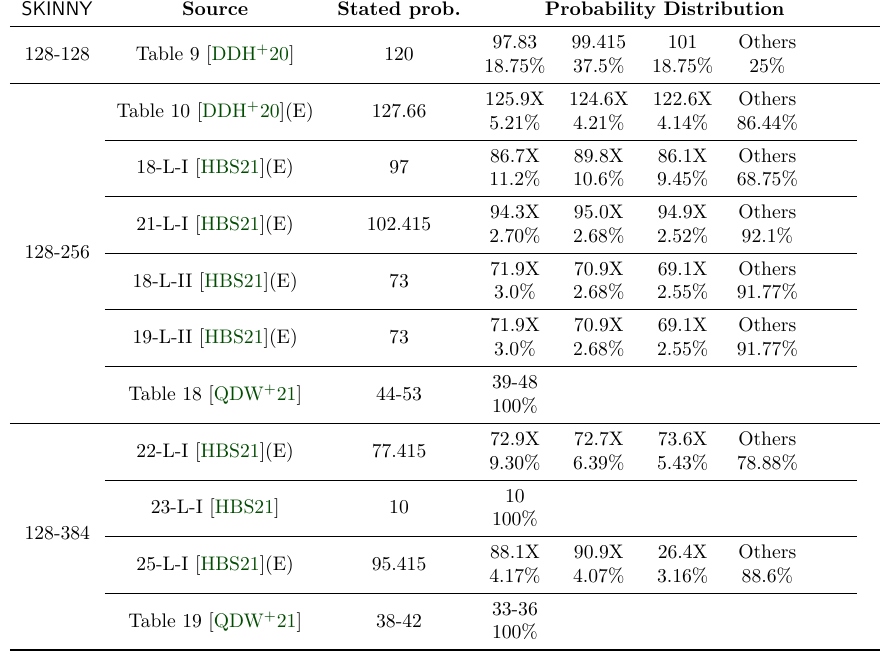
Table 7: The probability distribution estimation for each differential characteristic from Table 2. “Stated prob.” refers to the − log The first row in each probability distribution refers to the probability (in − log percentage of keys having this probability shown below them. ‘X’ indicates a range from 0 to 9.